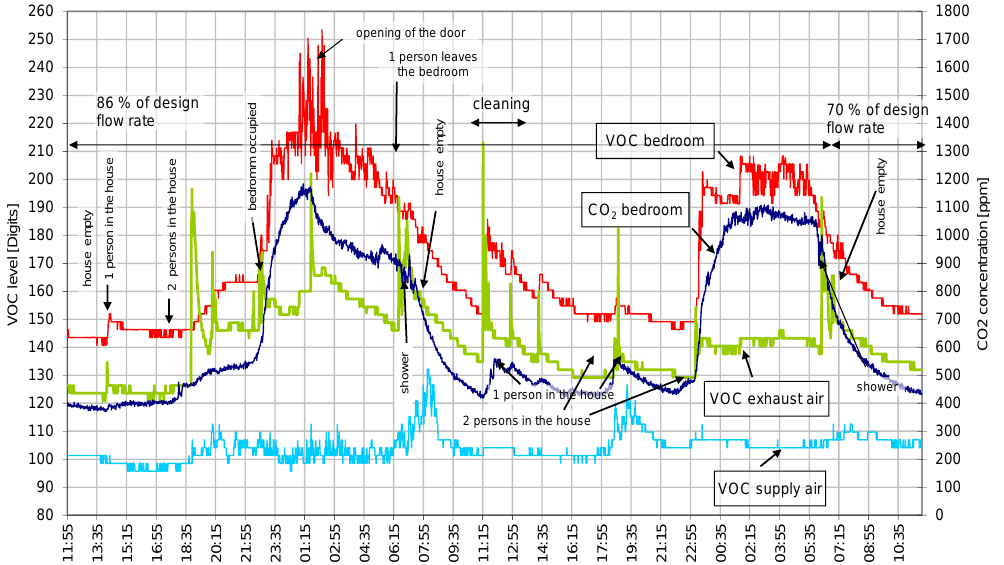
Figure 2. Measurements of VOC and CO 2 in room air and exhaust air in a passive house bedroom over 2 days.